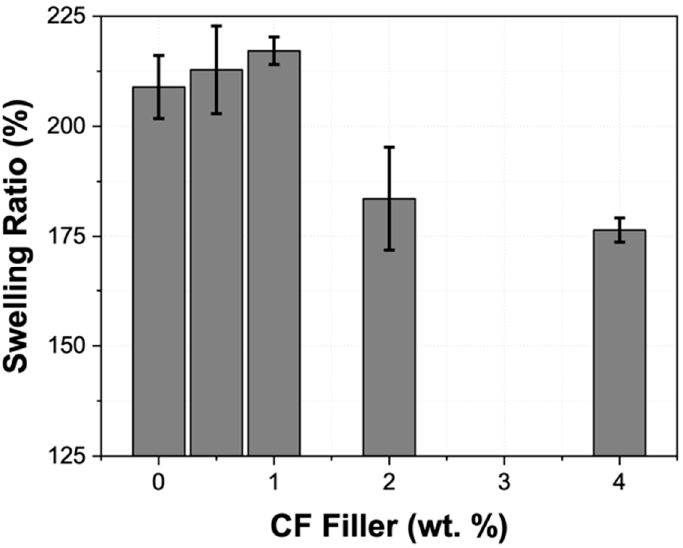
Figure 6. Swelling ratio (%) as a function of the amount of CF filler in the PDMS